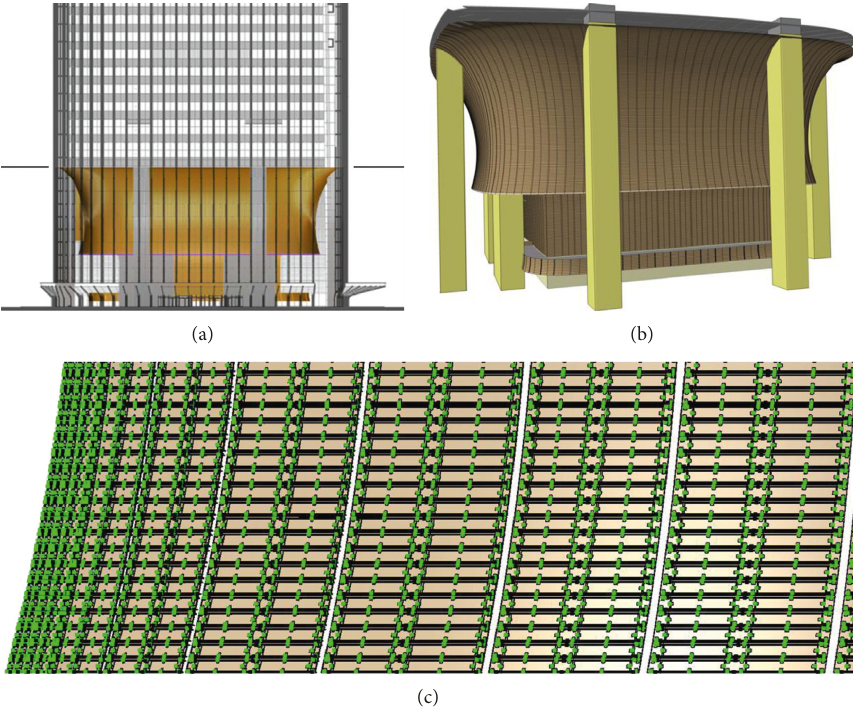
Figure 4: Surface optimization model of the